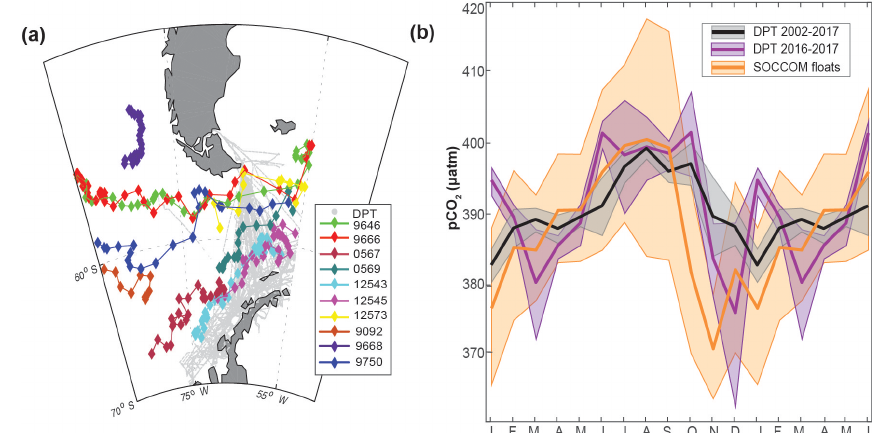
Figure 7. (a) Trajectories of Drake Passage-transiting SOCCOM floats included in this analysis. Colored diamonds represent the locations of surface measurements for each float. Data from floats collected east of 55 ◦ W and west of 90 ◦ W are not included in this analysis. Gray dots represent observations from the DPT. (b) Mean surface ocean p CO 2 seasonal cycle estimate for black: underway Drake Passage Time-series data for years 2002–2016; purple: DPT for years 2016–2017 to match years covered by the floats; and orange: SOCCOM floats. Seasonal cycles are shown on an 18-month cycle, calculated from a monthly mean time series with the atmospheric correction to year 2017. Shading represents 1 standard error accounting for the spatial and temporal heterogeneity of the sample and the measurement error (2.7% or ± 11µatm at a p CO 2 of 400µatm for floats; ± 2µatm for DPT data) combined using the square root of the sum of